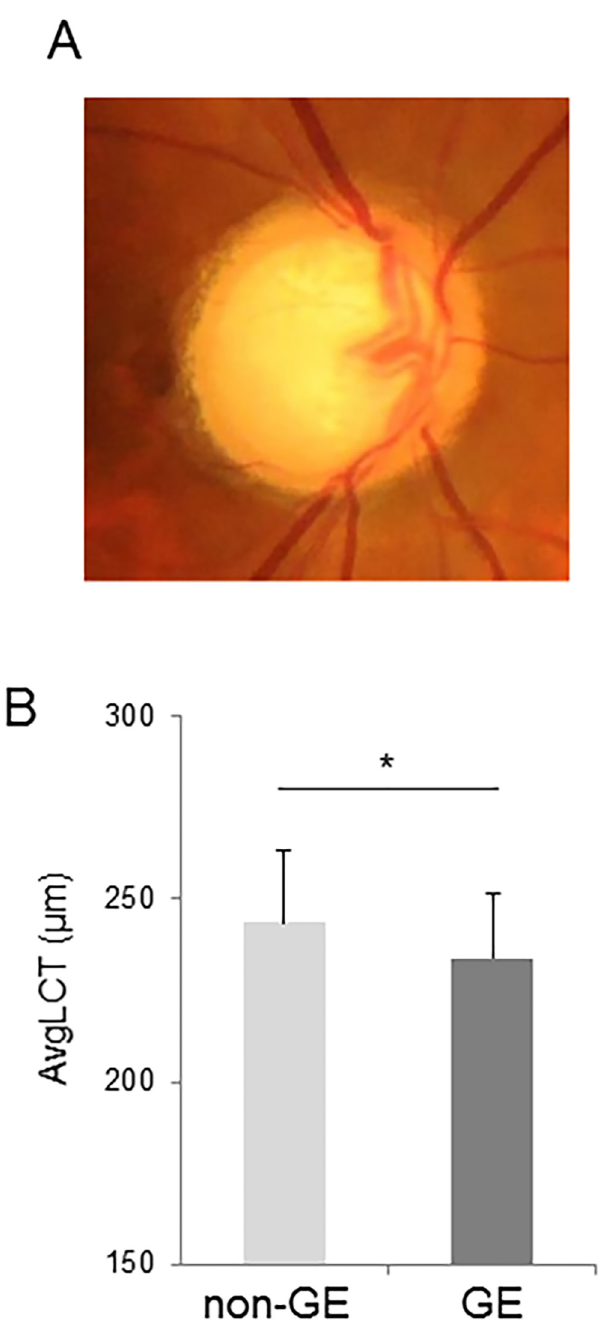
Fig 4. Difference in the association between average lamina cribrosa thickness (avgLCT) and HFA MD in glaucoma patients with generalized enlargement (GE)-type discs and non-GE discs. (A) Representative appearance of a GE disc. (B) Comparison of avgLCT in patients with non-GE and GE discs.